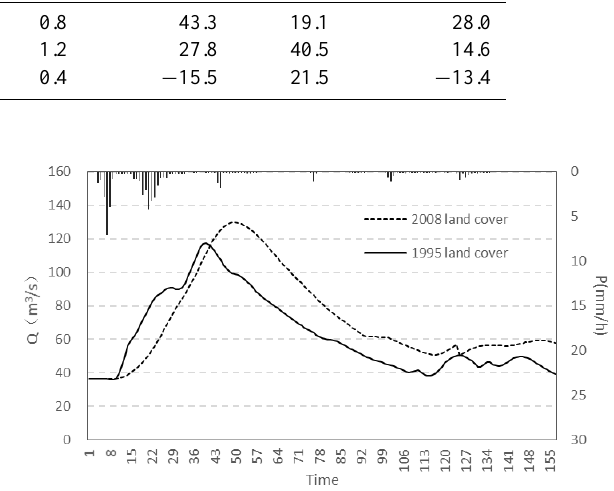
Figure 4. Simulated discharge hydrographs under 1995 and 2008 land cover for storm event No.